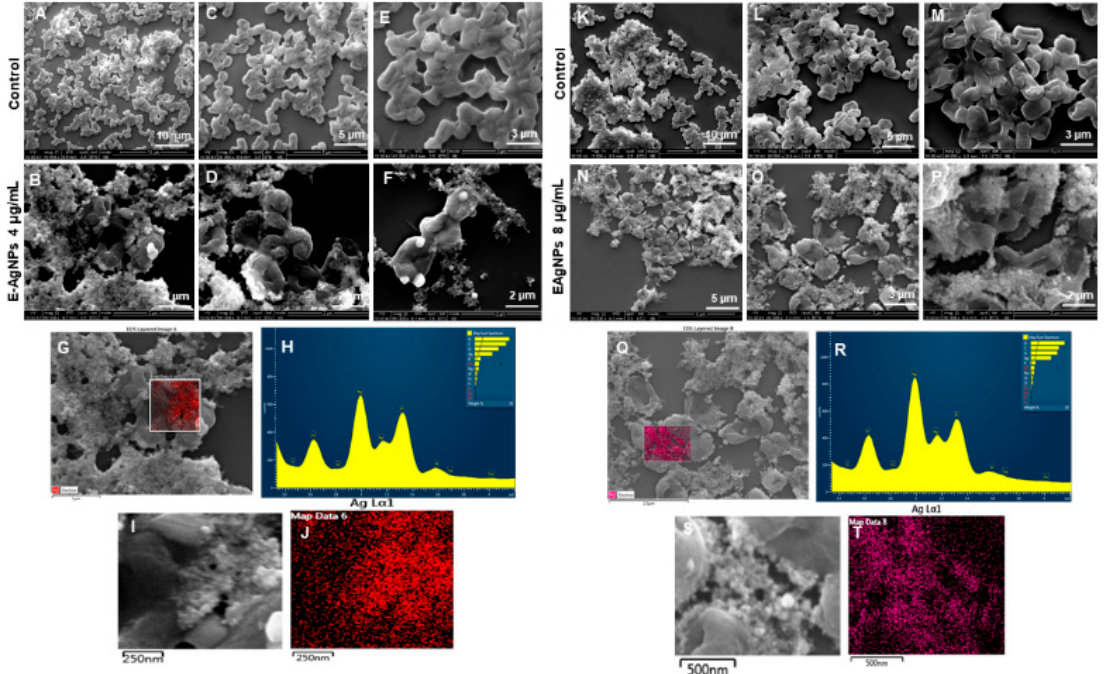
Figure 13. SEM analysis of E. coli cells after treatment with E-AgNPs. ( A – E ) Control cells and ( B – F ) cells treated with 4 μ g/mL of E-AgNPs at different scales. ( G ) Scanned image of treated cells, ( H ) EDX spectrum of the chosen area-showing peak for silver element. ( I , J ) Elemental mapping of the selected area showing silver elements in the treated cells (red color). ( K – M ) Control cells and ( N – P ) cells treated with 8 μ g/mL of E-AgNPs at different scales. ( Q ) Scanned image of treated cells, ( R ) EDX spectrum of the chosen area showing peak for silver element, ( S , T ) elemental mapping of the selected area showing silver elements in the treated cells (pink color).